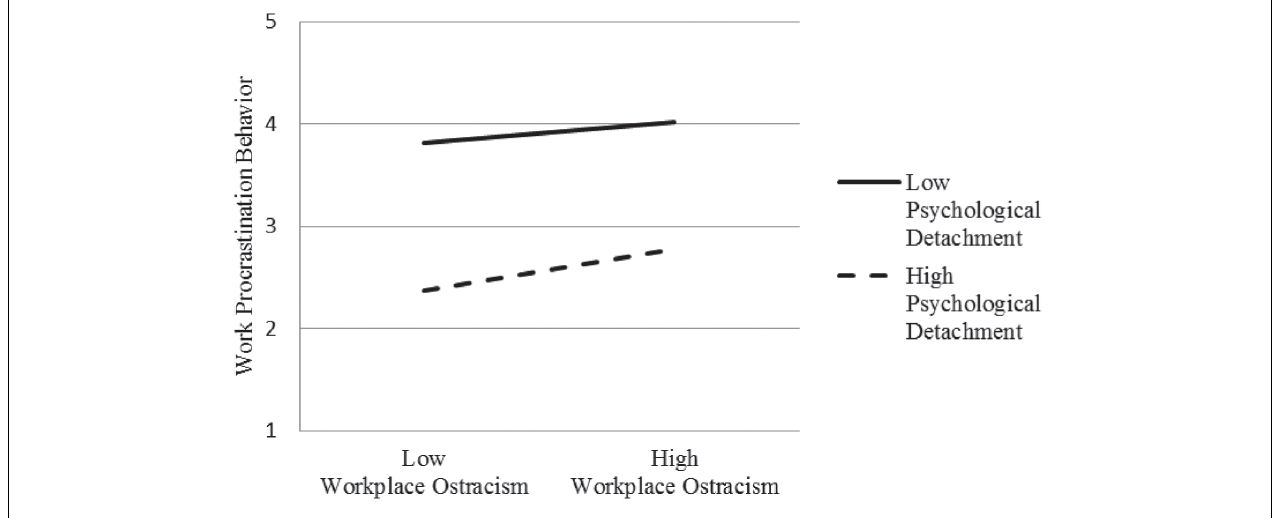
FIGURE 3 | Interaction effect of psychological